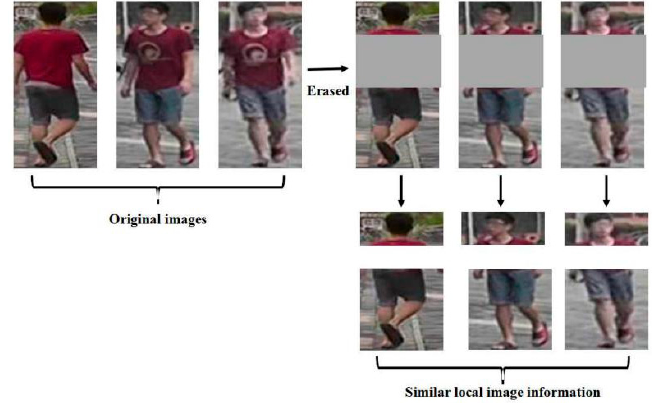
Figure 1. The details of the remaining areas are still similar after erasing part of the original image.